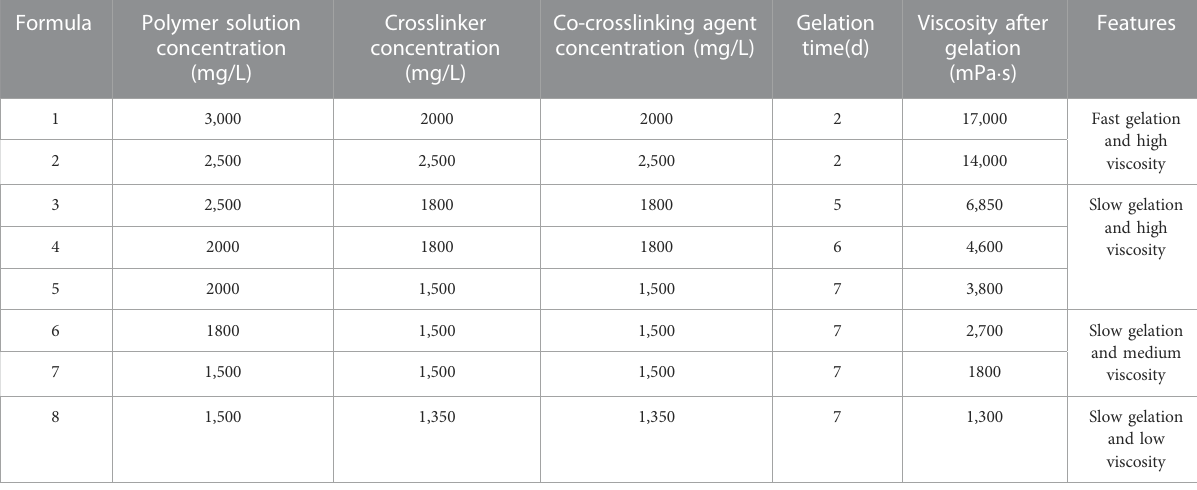
TABLE 5 Gel formulation and post-gelling parameters.